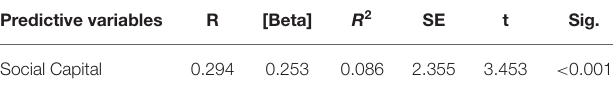
TABLE 5 | Regression and effect coefficients of social capital in happiness. Predictive variables R [Beta] R 2 SE t Sig.